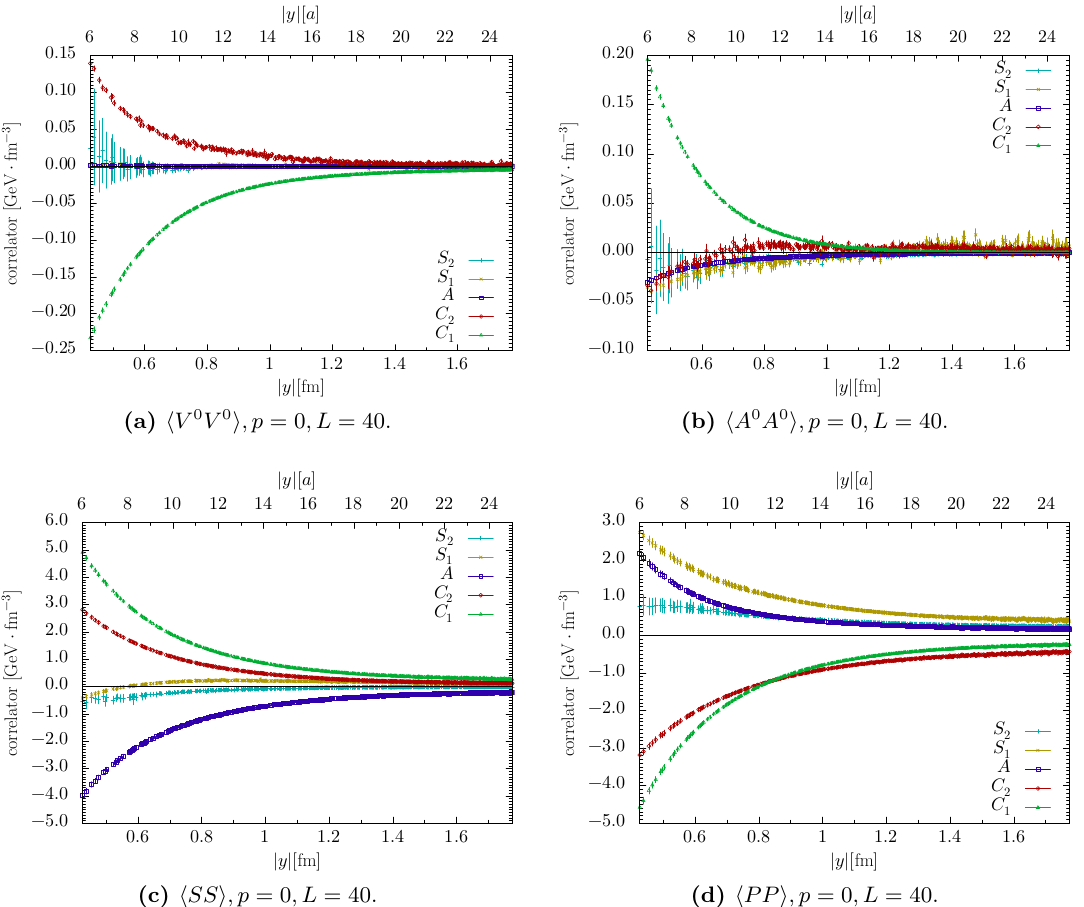
Figure 11. Correlators of the four current combinations considered in this work. The contributions of all graphs are shown separately, except for D , which has huge statistical